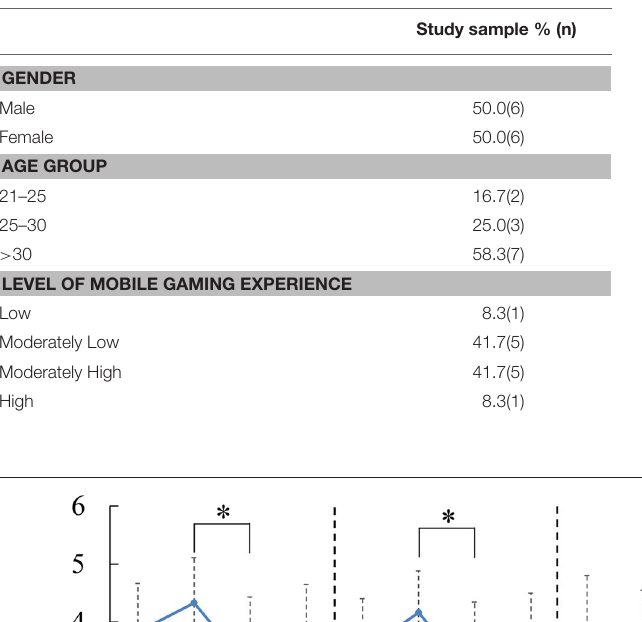
TABLE 1 | List of sociodemographic factors in the classifier study sample.